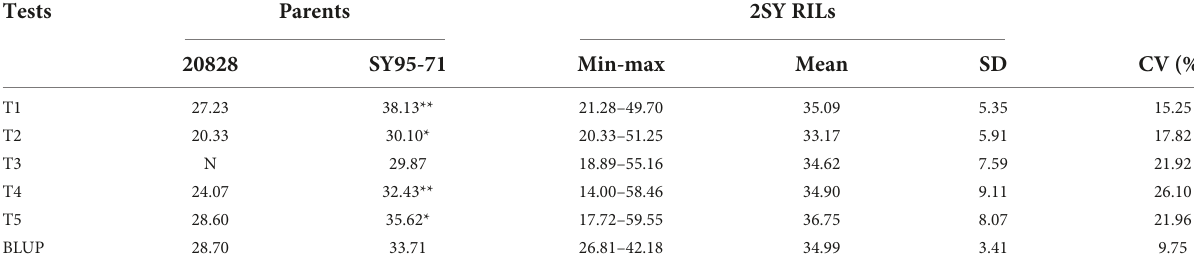
TABLE 1 Phenotypic variation of maximum root length (MRL) for five tests in 20828/SY95-71(2SY) population.